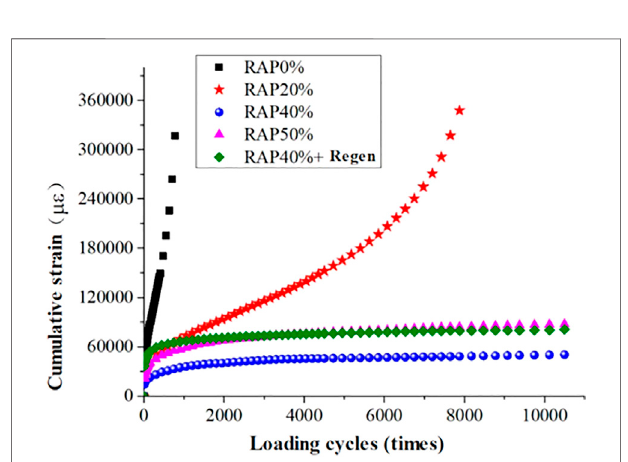
FIGURE 5 | Dynamic creep curves of fi ve different AC-20 ordinary asphalt recycled mixes.